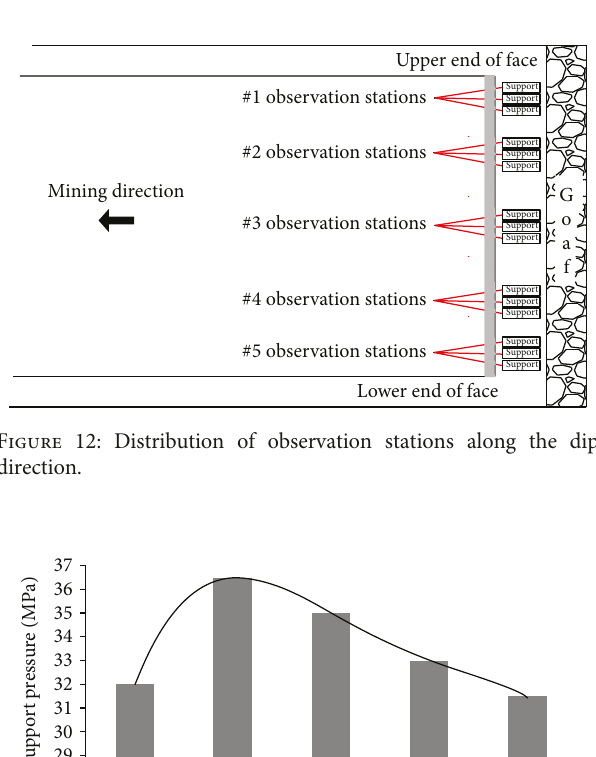
Figure 9: Distribution of maximum shear stress.